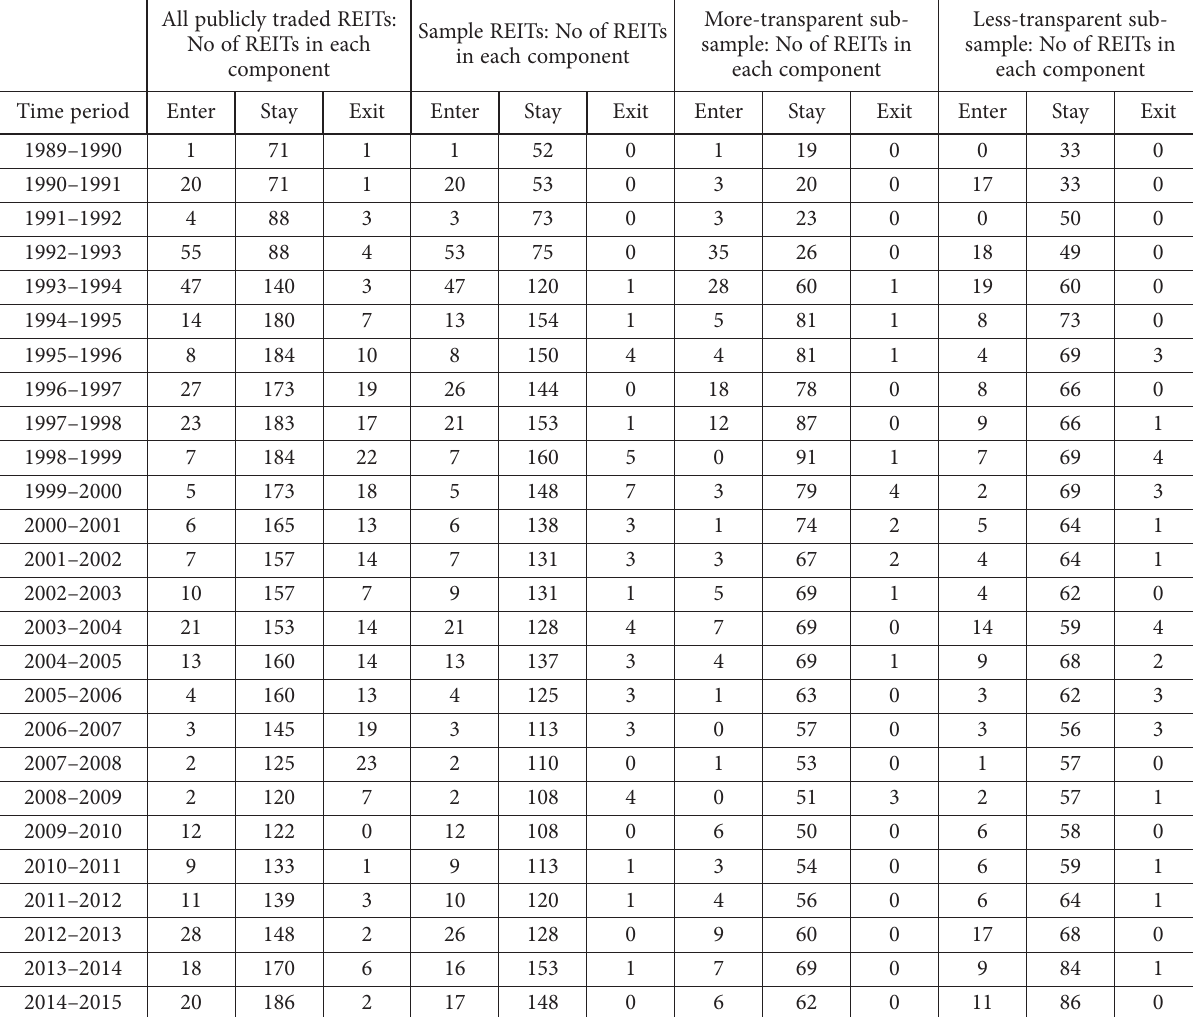
Table 2. Evolution of the number of sample REITs for the entire sample and various